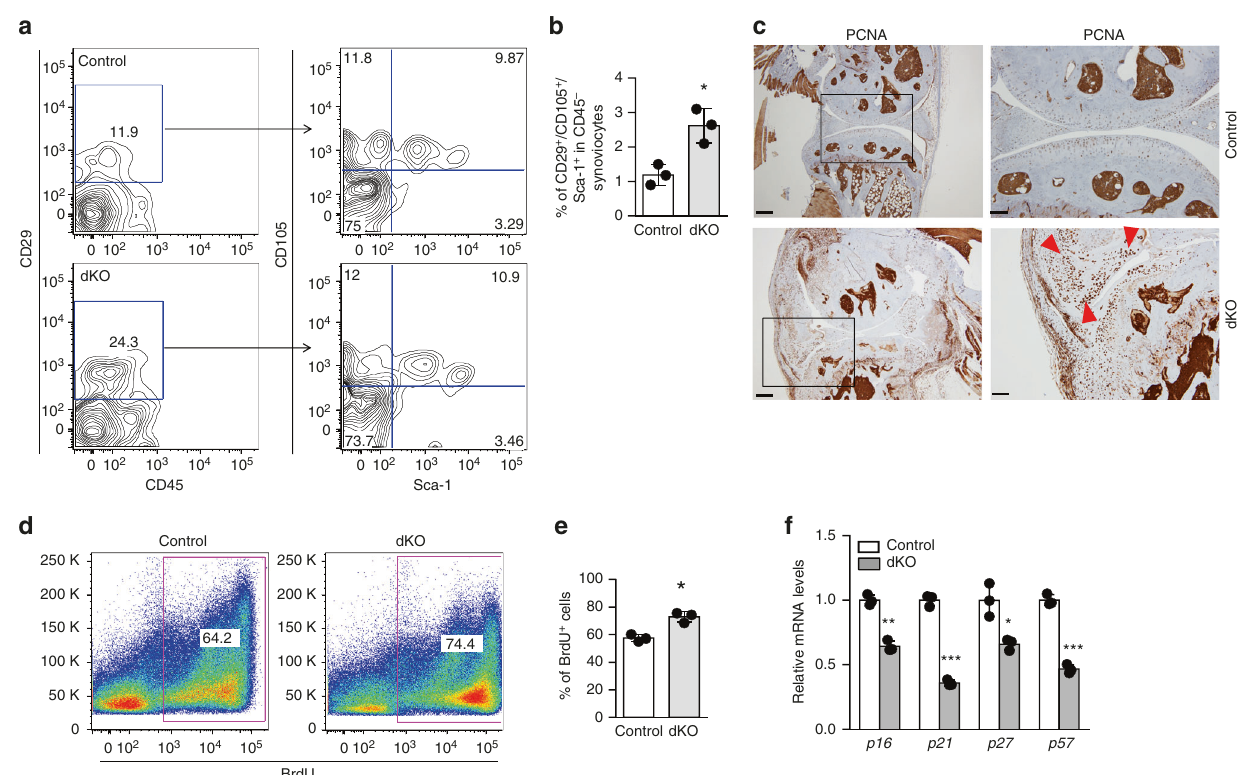
Fig. 4 Proliferation of mesenchymal stem/progenitor cells is enhanced in miR-204 /- 211 dKO mice. a , b Representative fl ow cytometry pro fi le ( a ) and quanti fi cation ( b ) of CD29 + /CD105 + /Sca-1 + cells in CD45 − synoviocytes freshly isolated from control and dKO mice. n = 3. c IHC results of proliferating cell nuclear antigen (PCNA) in control and dKO mice. Red arrowheads, PCNA-positive cells. Scale bars (left panels), 250 μ m. Scale bars (right panels), 100 μ m. d , e Representative fl ow cytometry pro fi le ( d ) and quanti fi cation ( e ) of BrdU-labeled CD45 − cells, which were in vivo labeled and freshly isolated. n = 3. f Quantitative RT-PCR analysis of p16 , p21 , p27 and p57 expression in CD45 − BMSCs from control or dKO mice. n = 3. Unpaired Student ’ s t test. Data are shown as the mean ± s.d. * P < 0.05, ** P < 0.01, *** P <